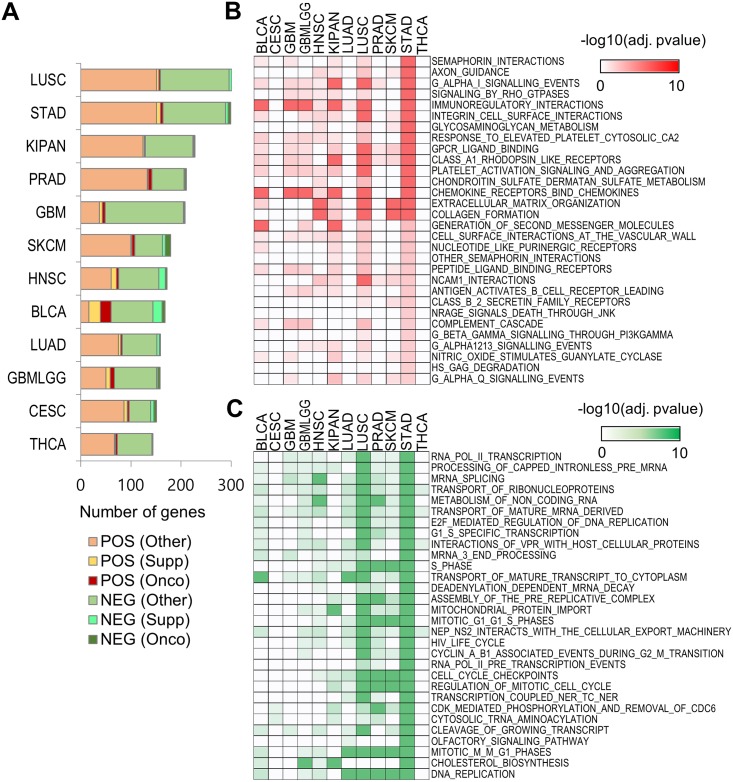
Association of RNA expression with ITH in 12 tumor types from TCGA.(A) Bar plot demonstrating comparison between the differential RNA gene expression in 12 tumor types from TCGA. BLCA: Bladder urothelial carcinoma; CESC: Cervical and endocervical cancers; GBM: Glioblastoma multiforme; GBMLGG: Glioma; HNSC: Head and neck squamous cell carcinoma; KIPAN: Pan-kidney cohort; LUAD: Lung adenocarcinoma; LUSC: Lung squamous cell carcinoma; PRAD: Prostate adenocarcinoma; SKCM: Skin cutaneous melanoma; STAD: Stomach adenocarcinoma; THCA: Thyroid carcinoma. POS: Positive; NEG: Negative; Onco: Oncogene; Supp: Suppress gene; Other: Other gene. (B) and (C) Heat map of functional categories of genes positively and negatively correlated with ITH, respectively.